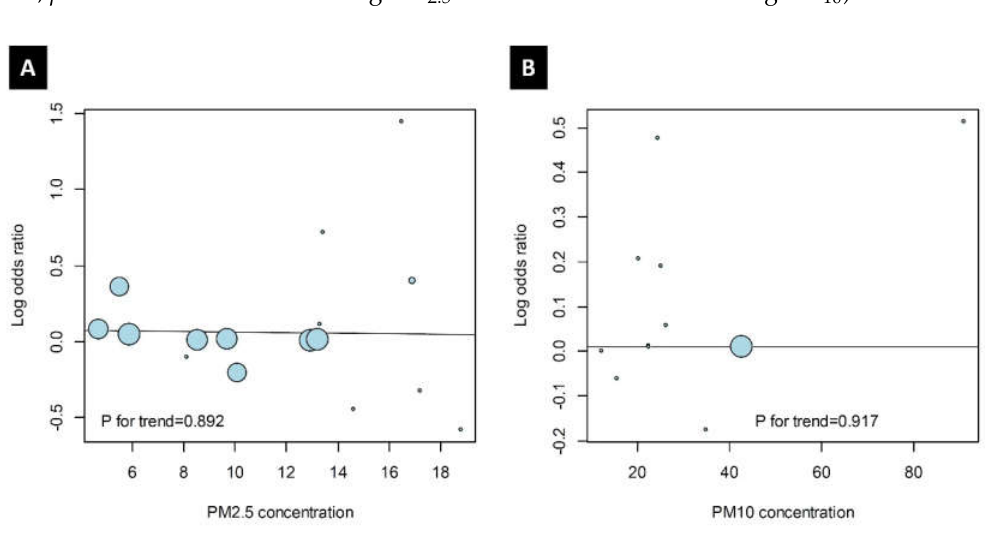
Figure 5. Funnel plot of publication bias in the (A)—PM 2.5 and (B)—PM 10 groups.